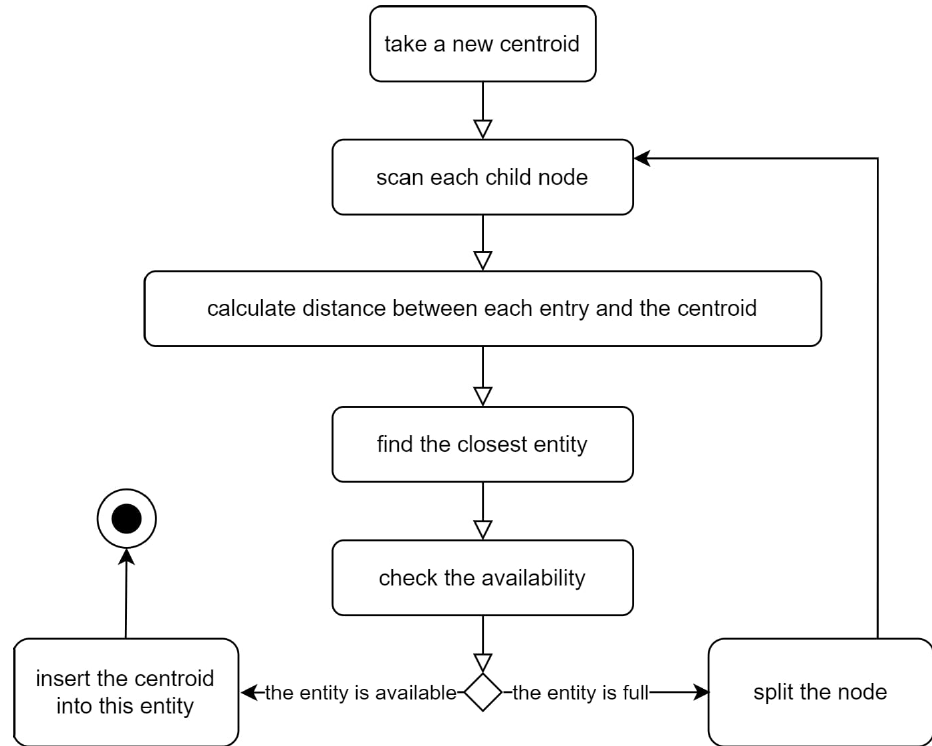
Figure 1. Locating a new centroid in a CF